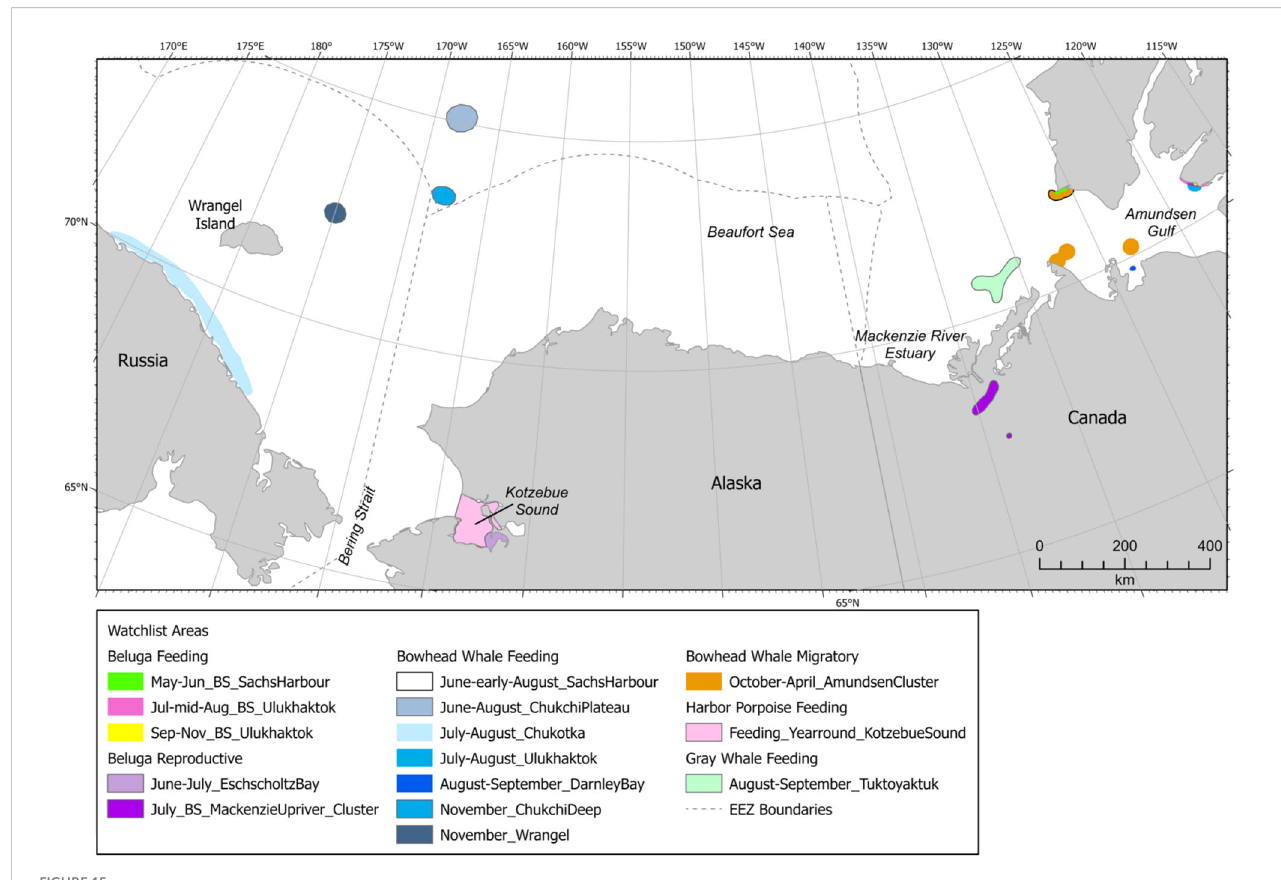
FIGURE 15 Arctic region watch list